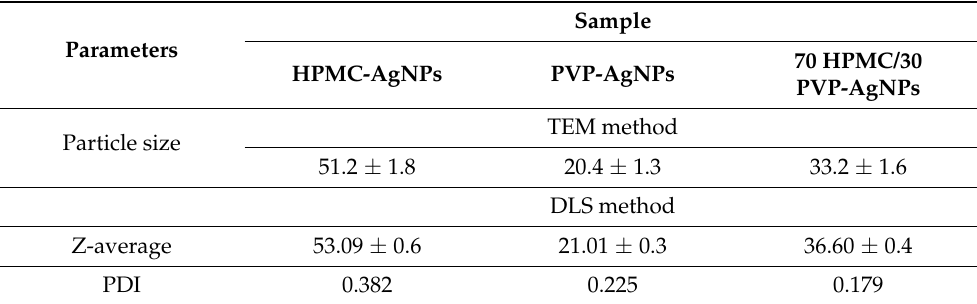
Table 2. Parameters obtained using the TEM and DLS methods on the silver nanoparticles from the studied polymer matrices: the mean particle size (nm) and the polydispersity index